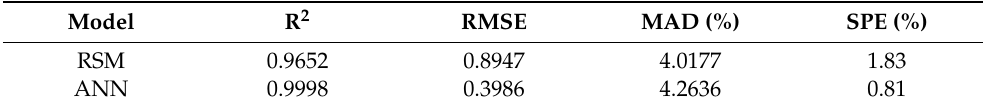
Table 4. Comparison of parameters between RSM and ANN.